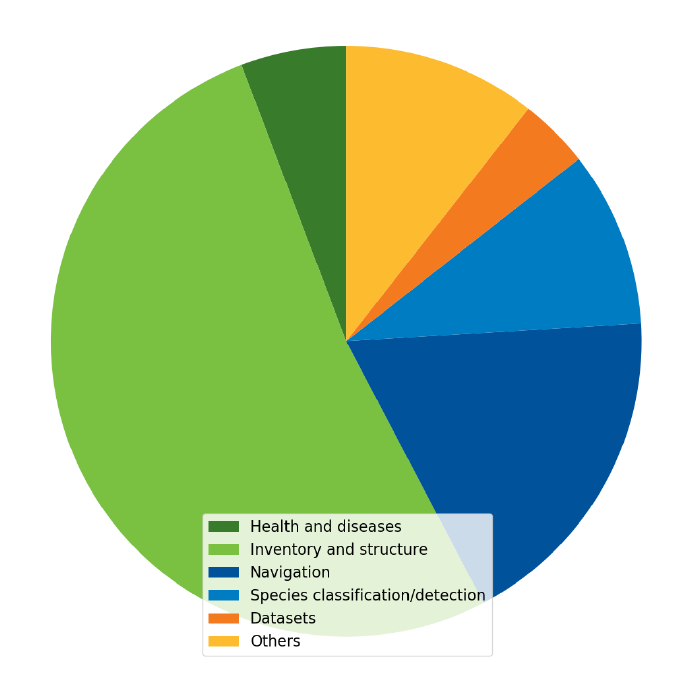
Figure 2. Category distribution of the reviewed